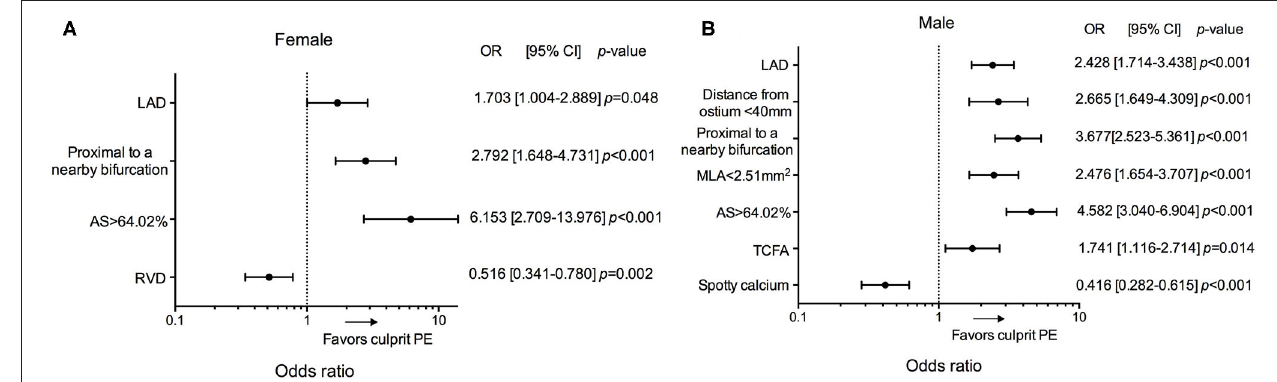
FIGURE 5 | Subgroup analyses of predictors for culprit PE in patients according to sex. Odd ratios for the presence of culprit PE in female (A) and male (B) according to LAD location, distance from the coronary ostium < 40mm, proximal to a nearby bifurcation, MLA < 2.51 mm 2 , AS > 64.02%, RVD, TCFA and spotty calcium. AS, area stenosis; CI, confidence interval; LAD, left anterior descending artery; MLA, minimal lumen area; OR, odds ratio; PE, plaque erosion; RVD, reference vessel diameter; TCFA, thin-cap fibroatheroma.